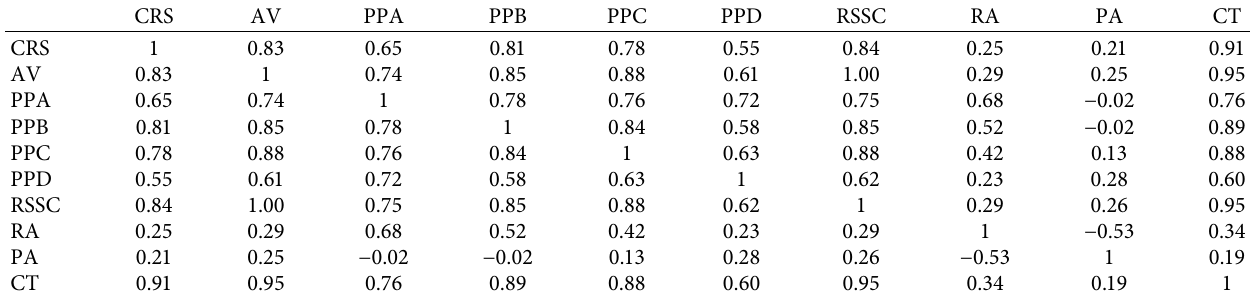
Table 2: Correlation coefficients among cutterhead torque and other key parameters on the stationary driving